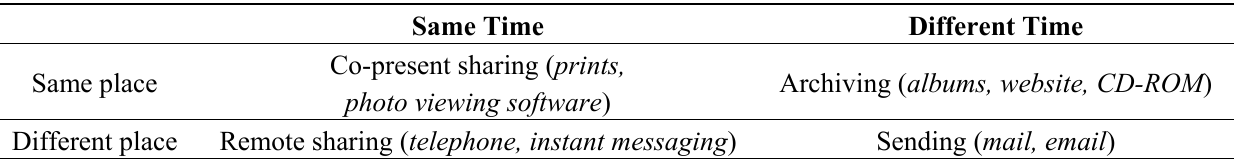
Table 1. Four different types of photoware [7], this study focuses on co-present sharing (shaded